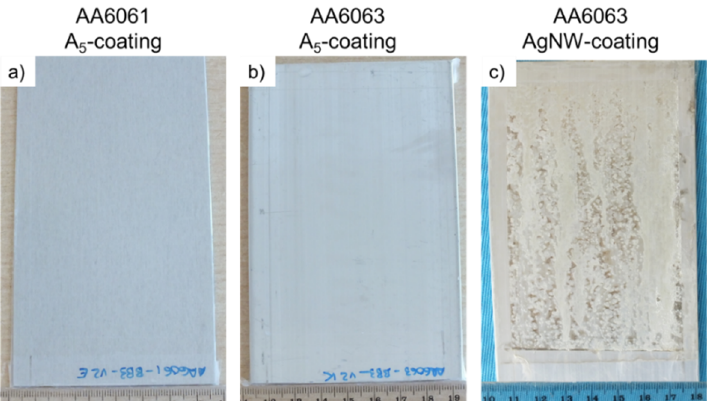
Figure 9. Representative photographs of ( a ) AA6061 T6 coated with Sol A; AA6063 T6 coated with ( b ) Sol A, and ( c ) Sol A-AgNW at 5 cm/min after 168 h of exposure in NSST.